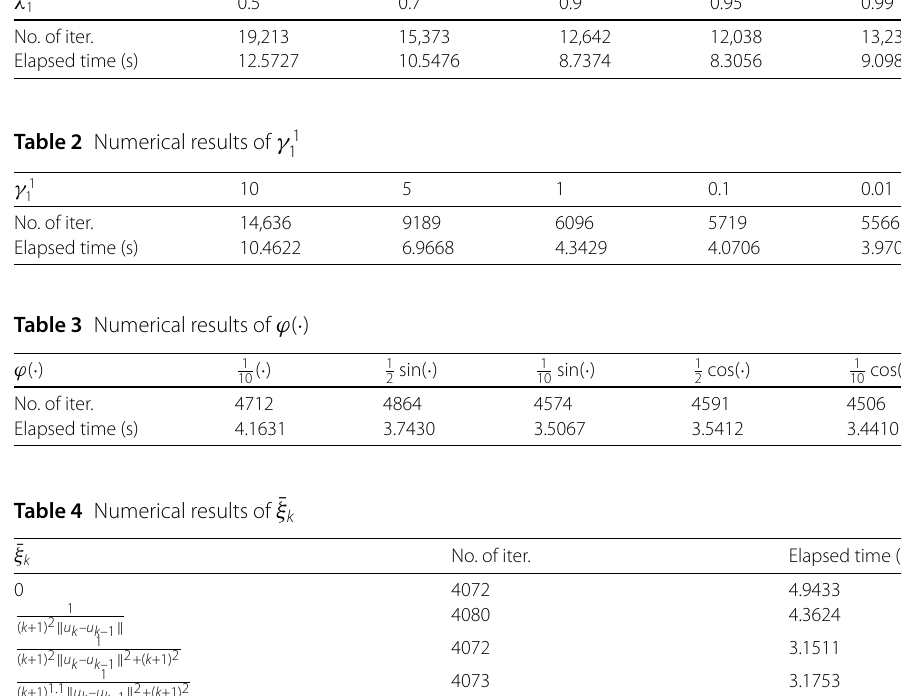
Table 1 Numerical results of λ 1 λ 1